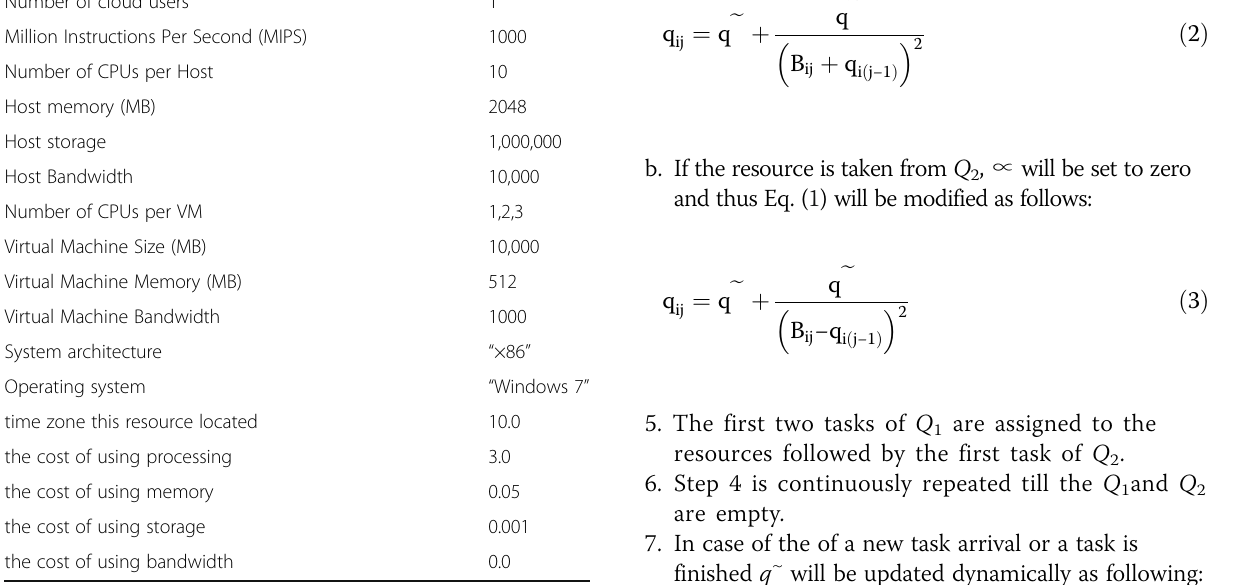
Table 6 CloudSim simulation parameters Number of cloud hosts 1 Number of cloud